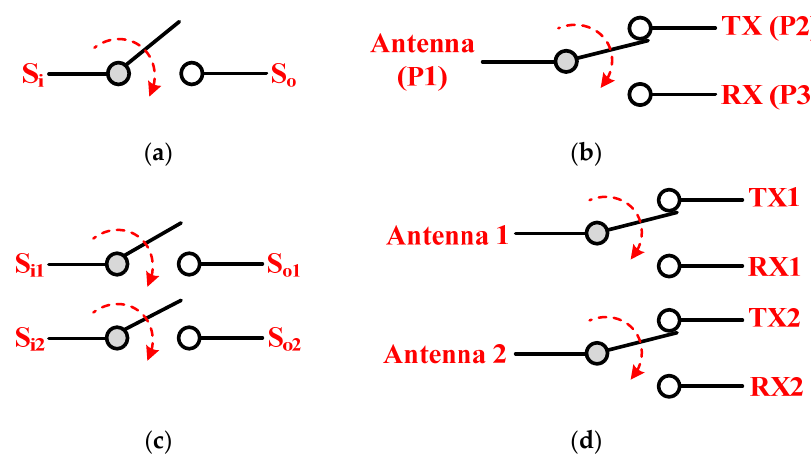
Figure 1. Illustrative diagrams of the ( a ) SPST, ( b ) SPDT, ( c ) DPST, and ( d ) DPDT switch. On-chip SPDT switch normally exhibits decent insertion loss, isolation, and power- handling capability (in the transmit mode). For the SPDT switch in Figure 1b, in the con-